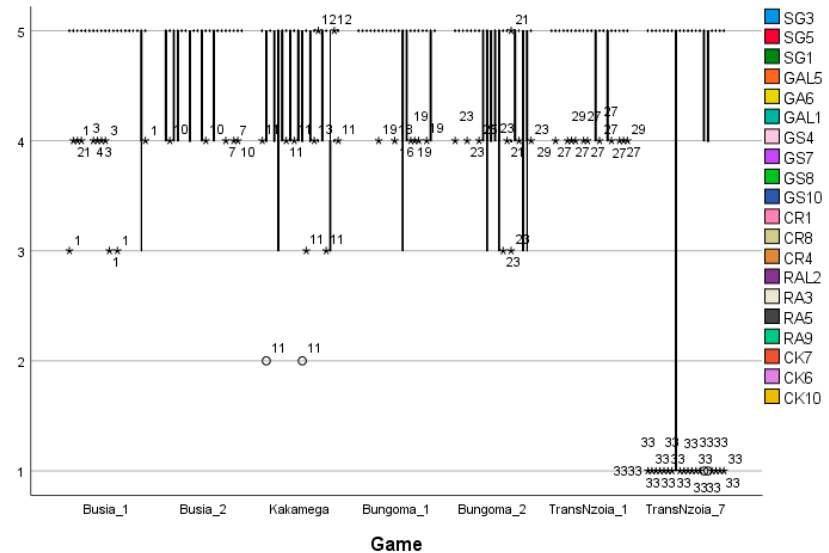
Figure A2. Game sessions disaggregated boxplot chart histograms.